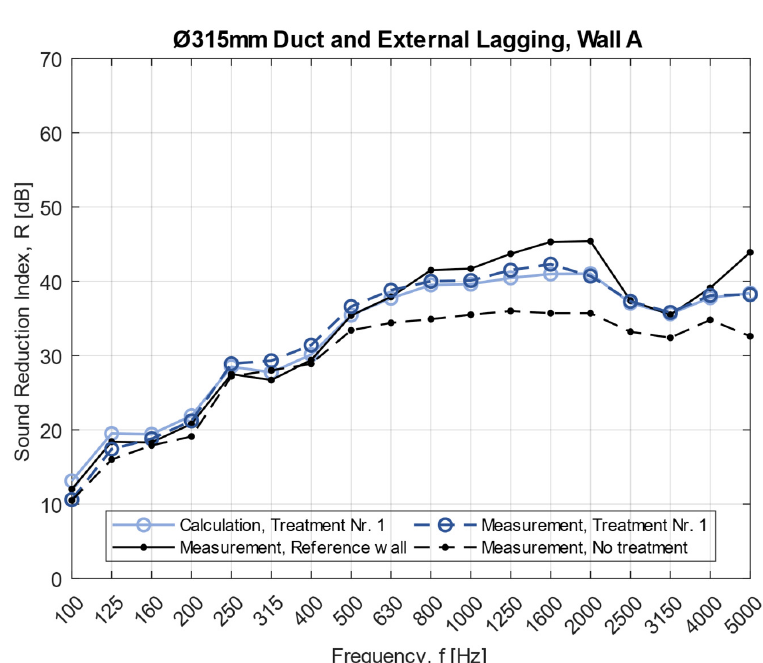
Figure A1. Theoretical models compared to measurements with external lagging as acoustic treatment. Ventilation duct with Ø315 mm through wall A with a sound reduction index of R w = 35 dB. External lagging is mounted at a partial length of 0.6 m (Treatment 1) with 50 mm stone wool, density of 100 kg/m 3 , closest to the wall.